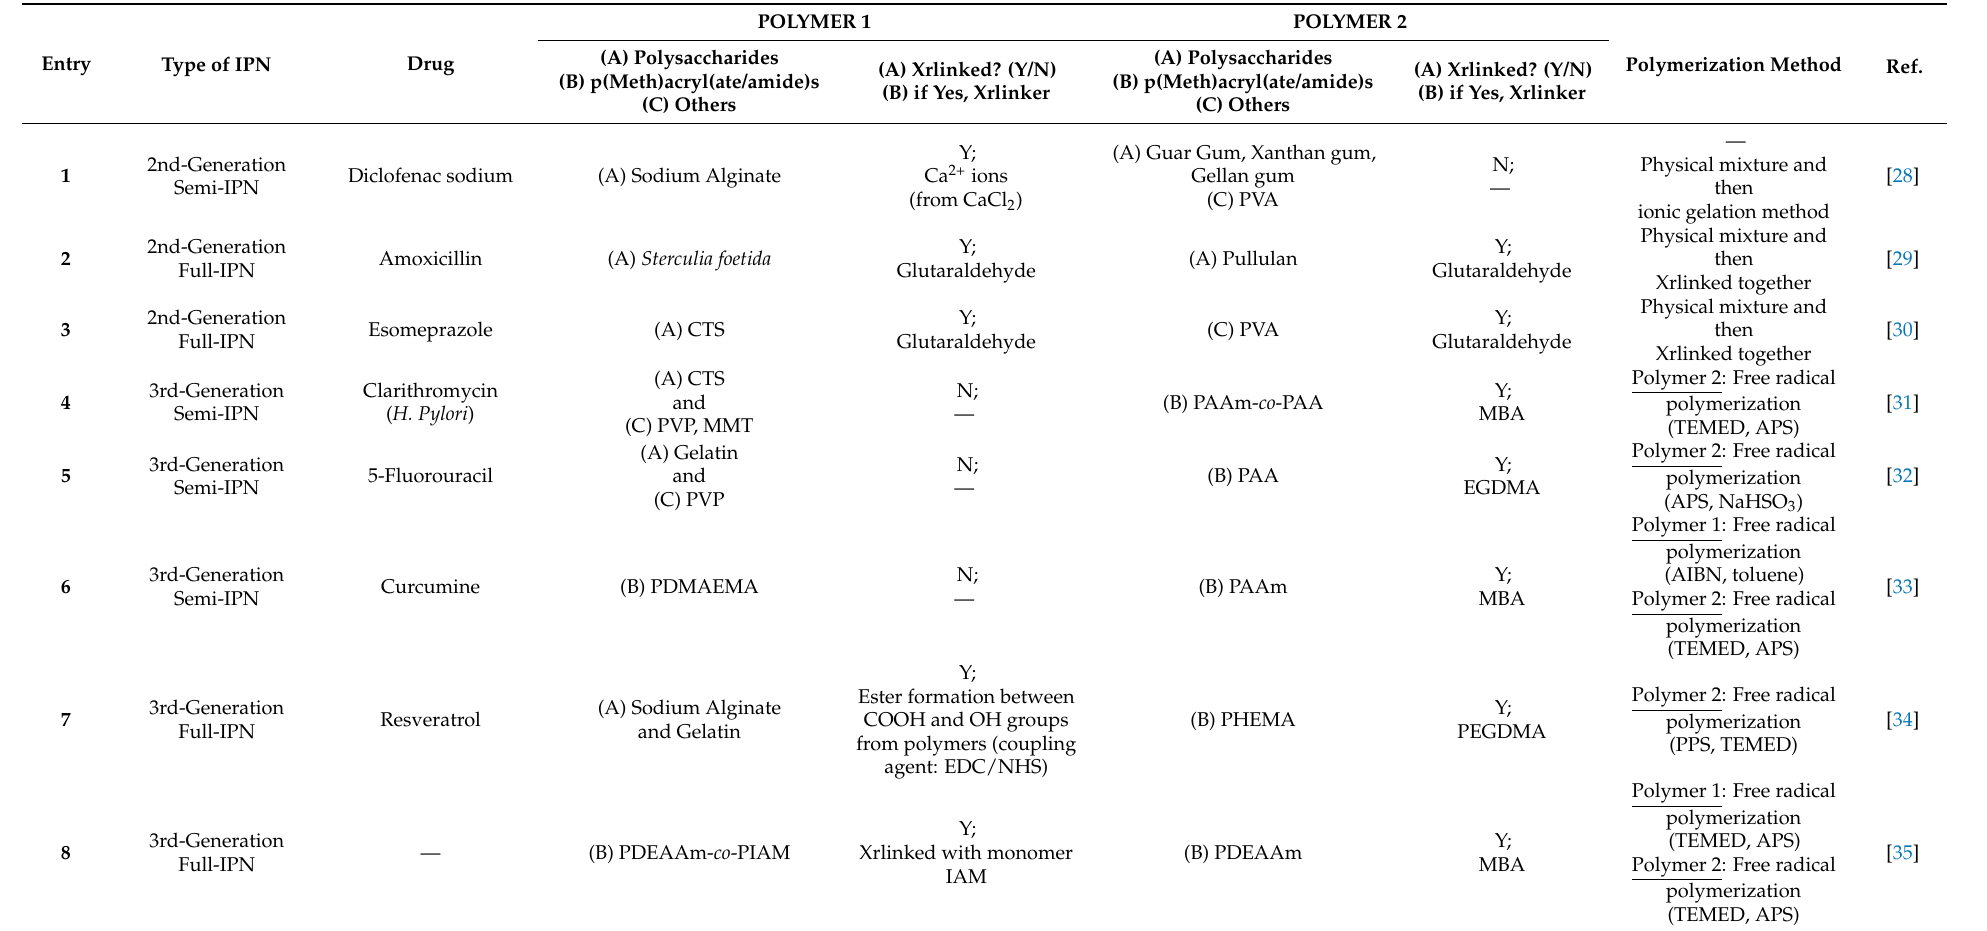
Table 6. Selected examples of IPN matrices prepared for their use as